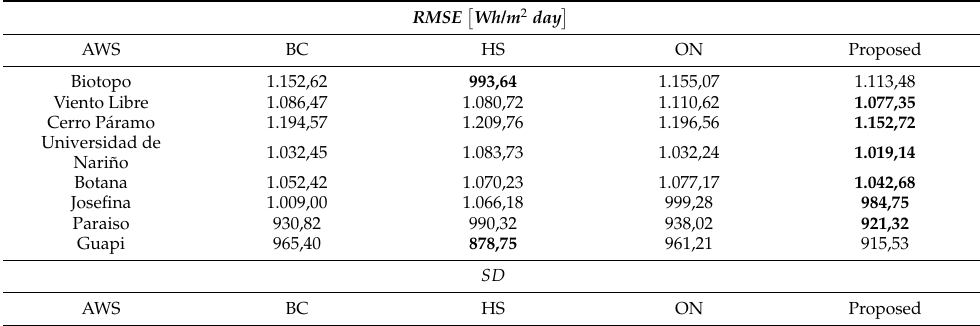
Table 12. Summary of the empirical model’s statistics results. The best result for each AWS is in